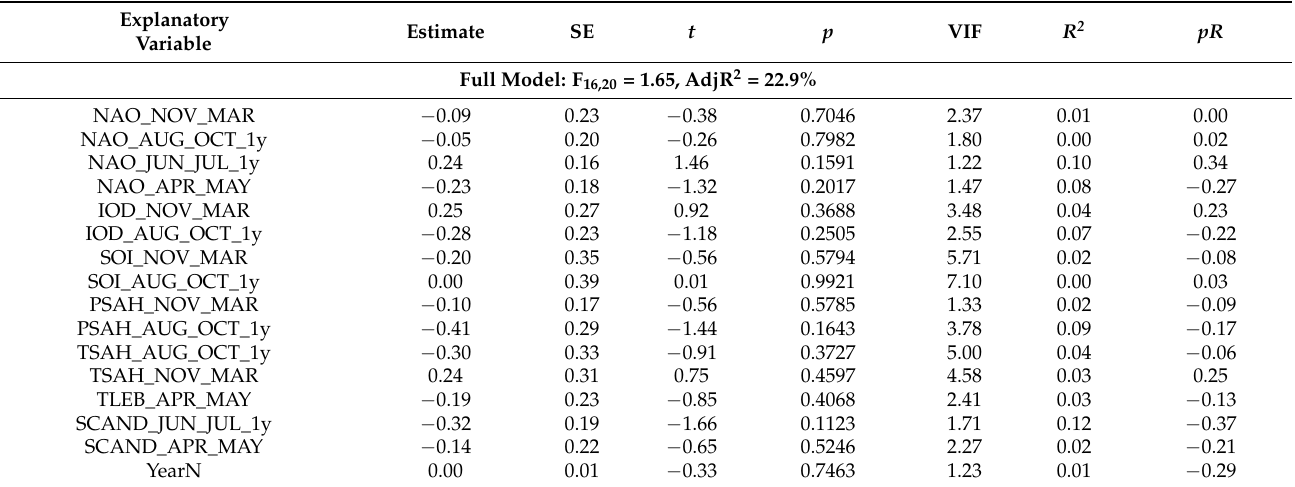
Table A9. Relationships between 15 climate variables and year in full models and Annual Anomaly of the timing of spring migration for the Lesser Whitethroat Curruca curruca caught at Bukowo, Poland, in 1982–2021. Symbols as in Tables 1 and A5.